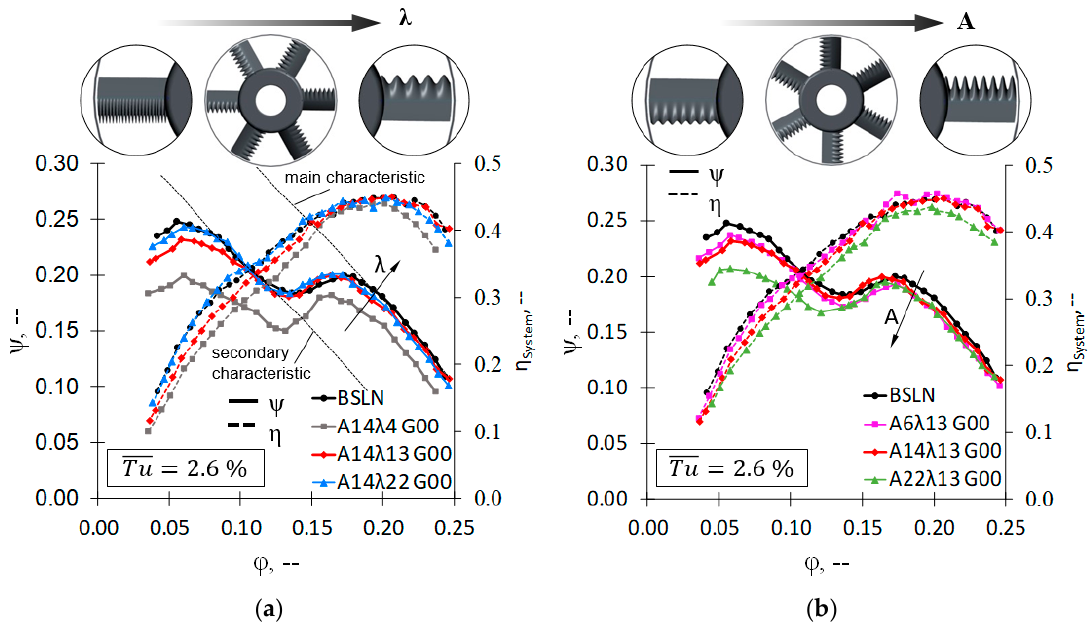
Figure 8. Characteristic curves of pressure vs. flow coefficient for different rotor configurations. ( a ) Varying serration wavelength; ( b ) Varying serration amplitude.